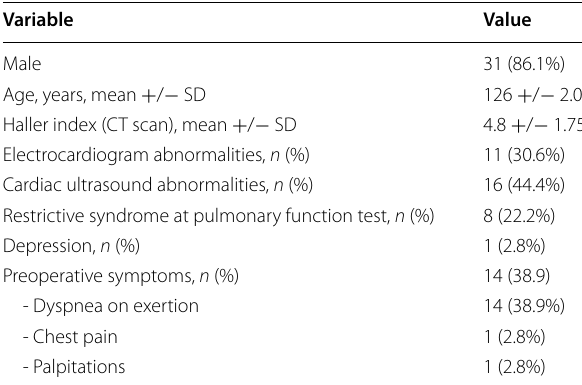
Table 2 Preoperative characteristic of